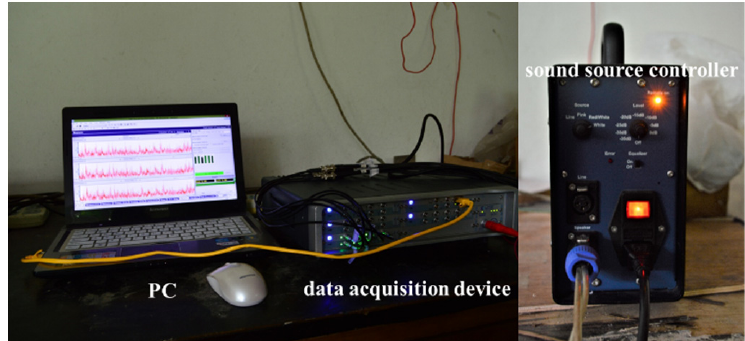
Figure 34. Testing equipment of sandwich plate STL experiment.